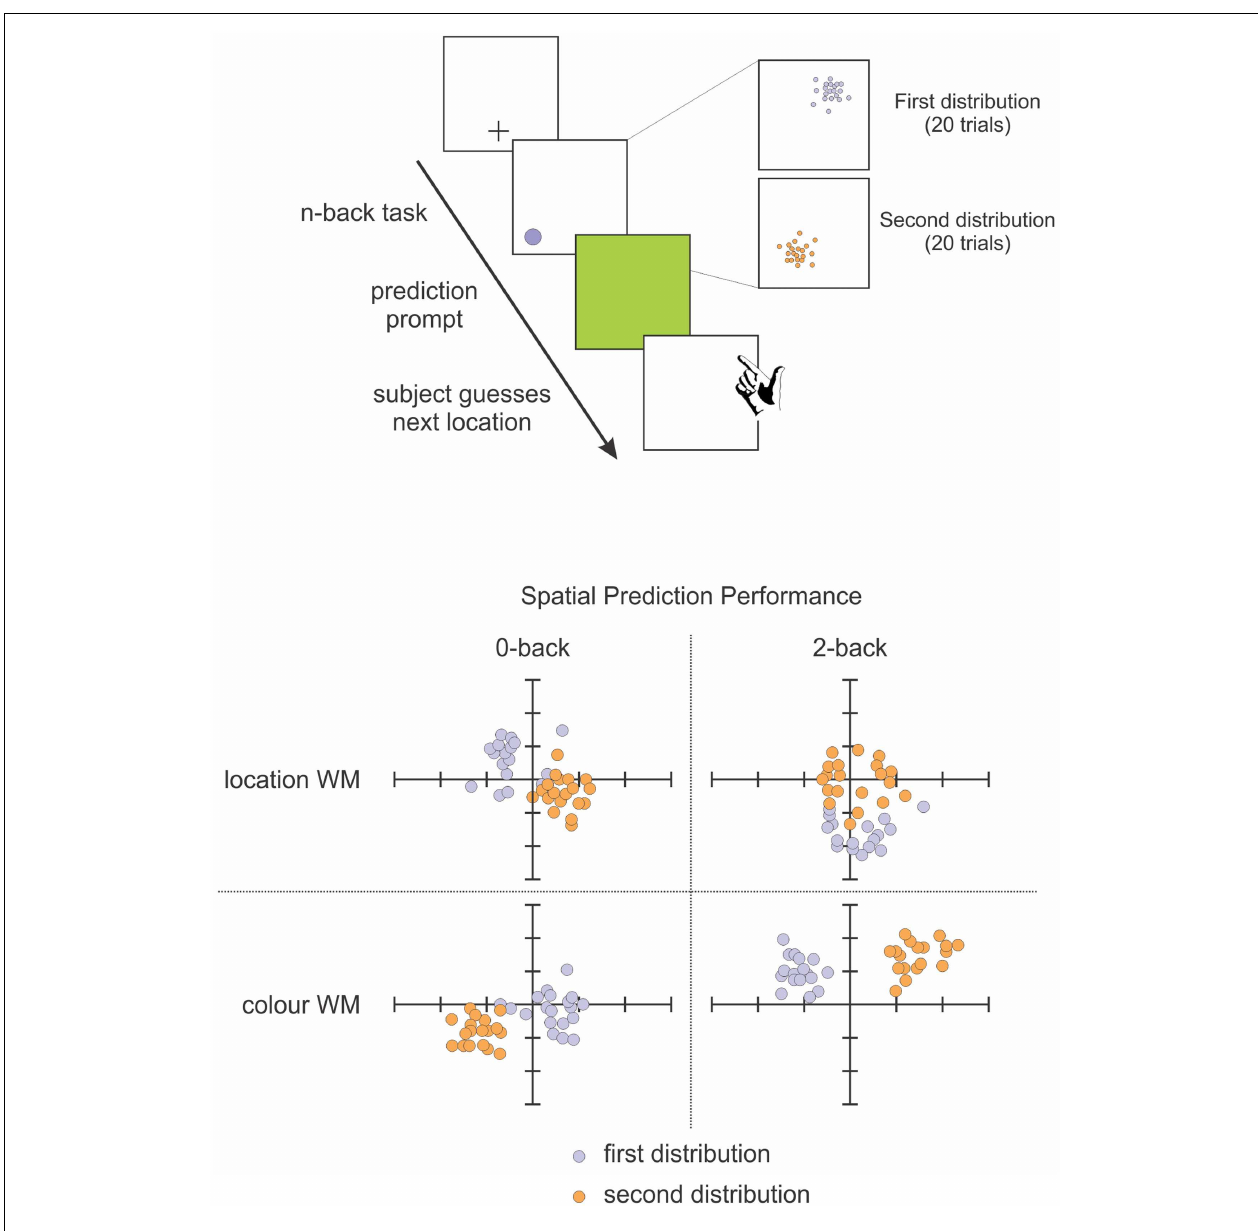
being switched to another quadrant for 20 trials. Lower panel shows performance from a representative participant on the spatial prediction component of the task in the 0-back (left) and 2-back (right) tasks.The participant’s predictions were less accurate when performing the 2-back spatial working memory task (upper right